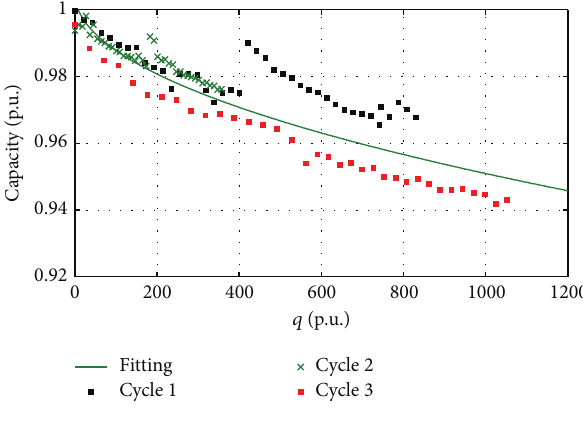
Figure 7: Ageing of the three